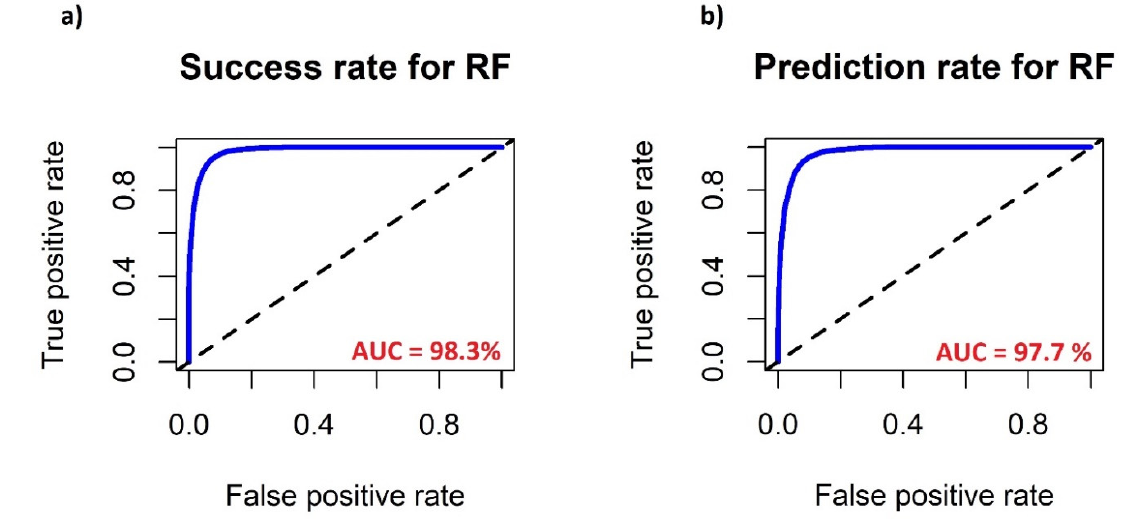
Figure 8. ( a ) Success and ( b ) prediction rate curves for random forest.